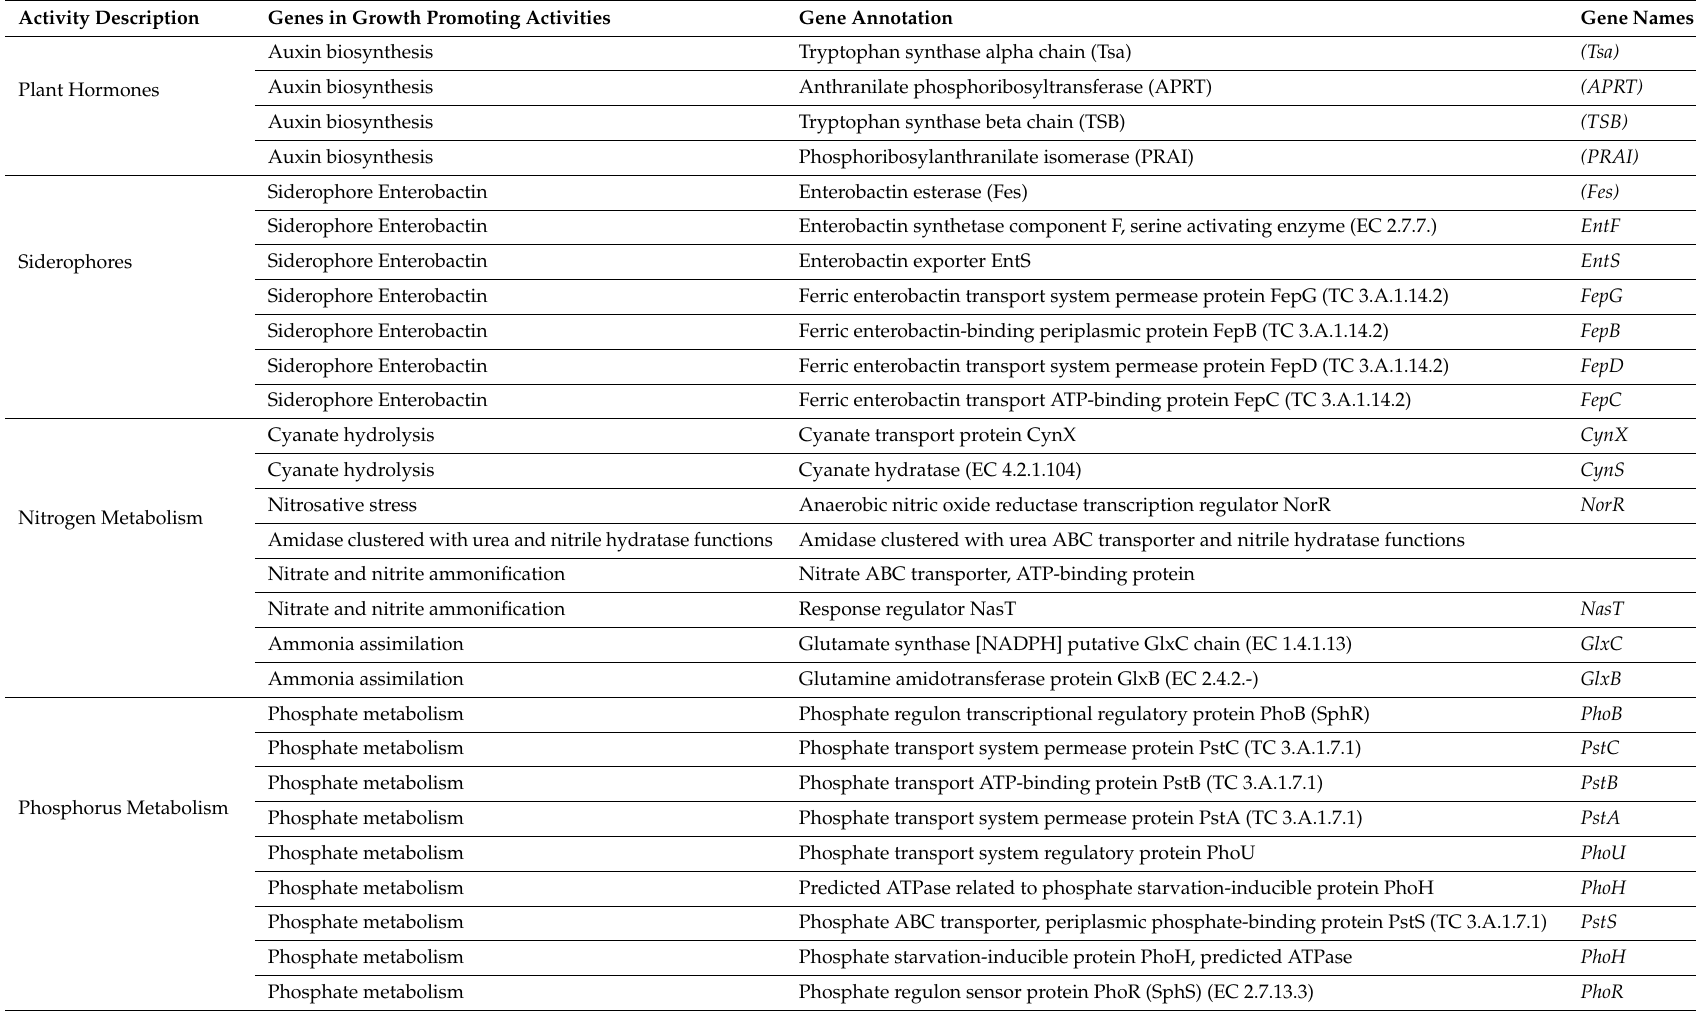
Table 2. Genes related to plant growth-promoting activities in the CS51